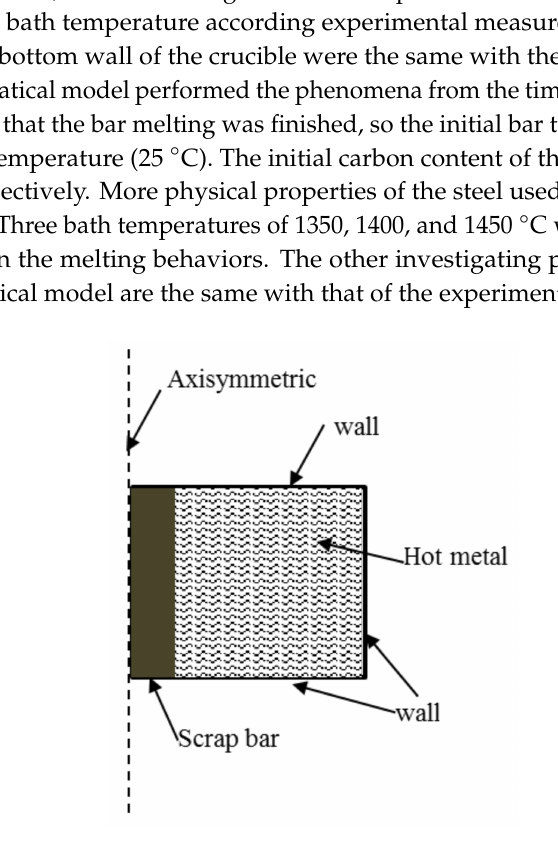
Figure 2. The calculation domain of the mathematical model. Table 3. Physical properties used for the simulations.